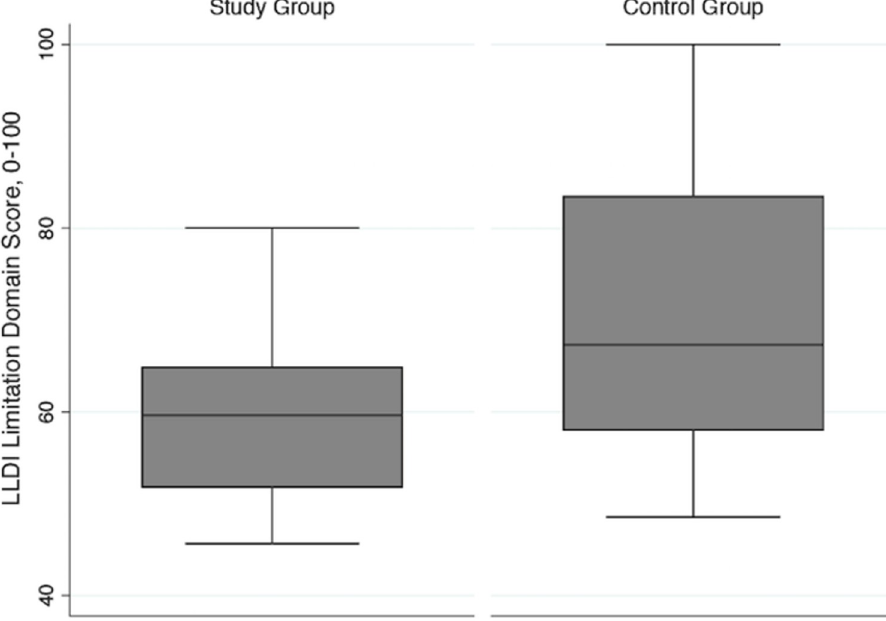
Fig 3. Late-life disability instrument limitation domain scores for the study group and control group. The box represents the 25 th to 75 th percentiles with the horizontal line inside the box representing the median score. The horizontal lines above and below the box represent the maximum (75 th percentile plus 1.5 � IQR) and minimum (25 th percentile minus 1.5 � IQR) scores. IQR = interquartile